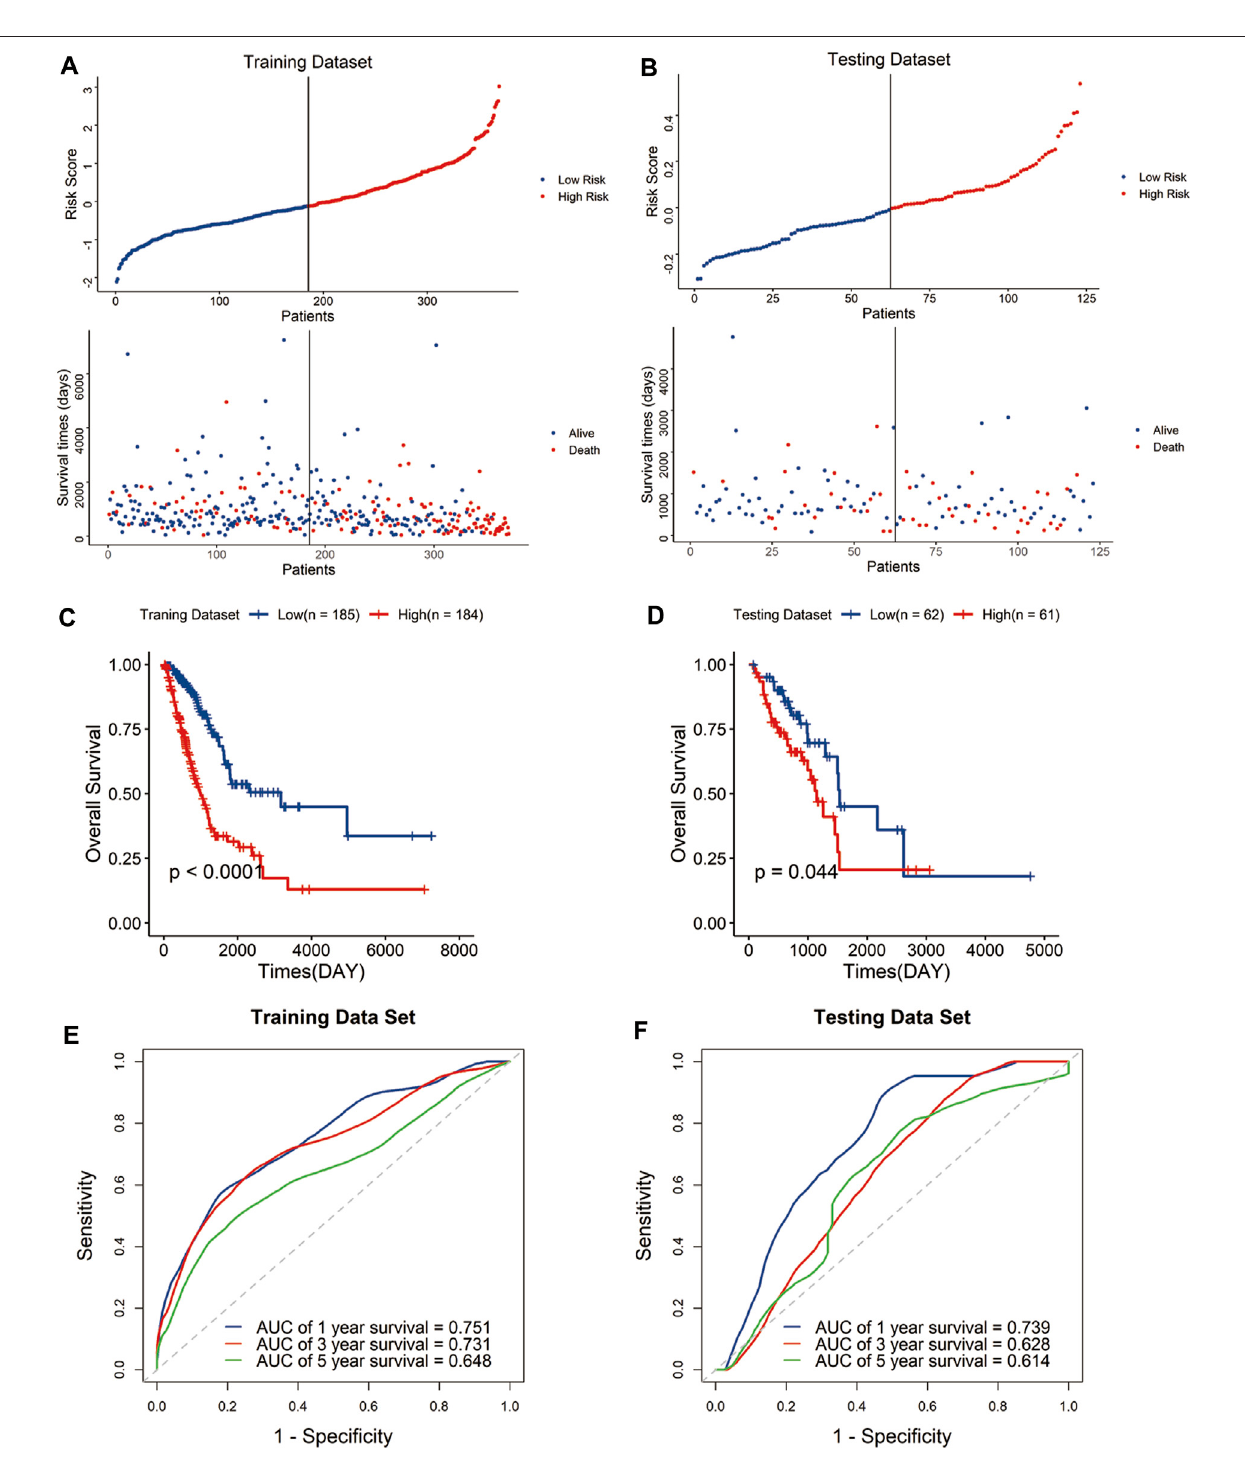
FIGURE 2 | Construction and validation of the risk signature in the TCGA cohort. Distribution of the risk score and survival status in the training dataset (A) and testing dataset (B) . Kaplan – Meier curves of overall survival for patients with LUAD based on the risk score in the training dataset (C) and testing dataset (D) . Receiver operating characteristic (ROC) curves of the signature for predicting the 1-, 3-, and 5-year survival in the training dataset (E) and testing dataset (F) .